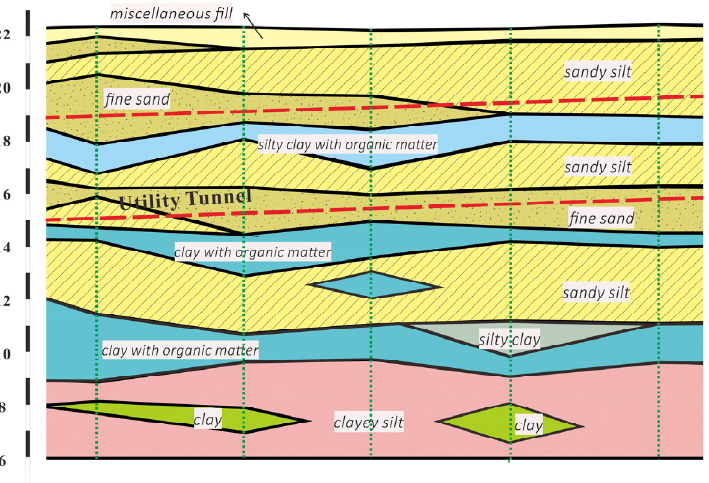
Figure 1. Geological profile of a section of the utility tunnel at Beijing Daxing International Air-